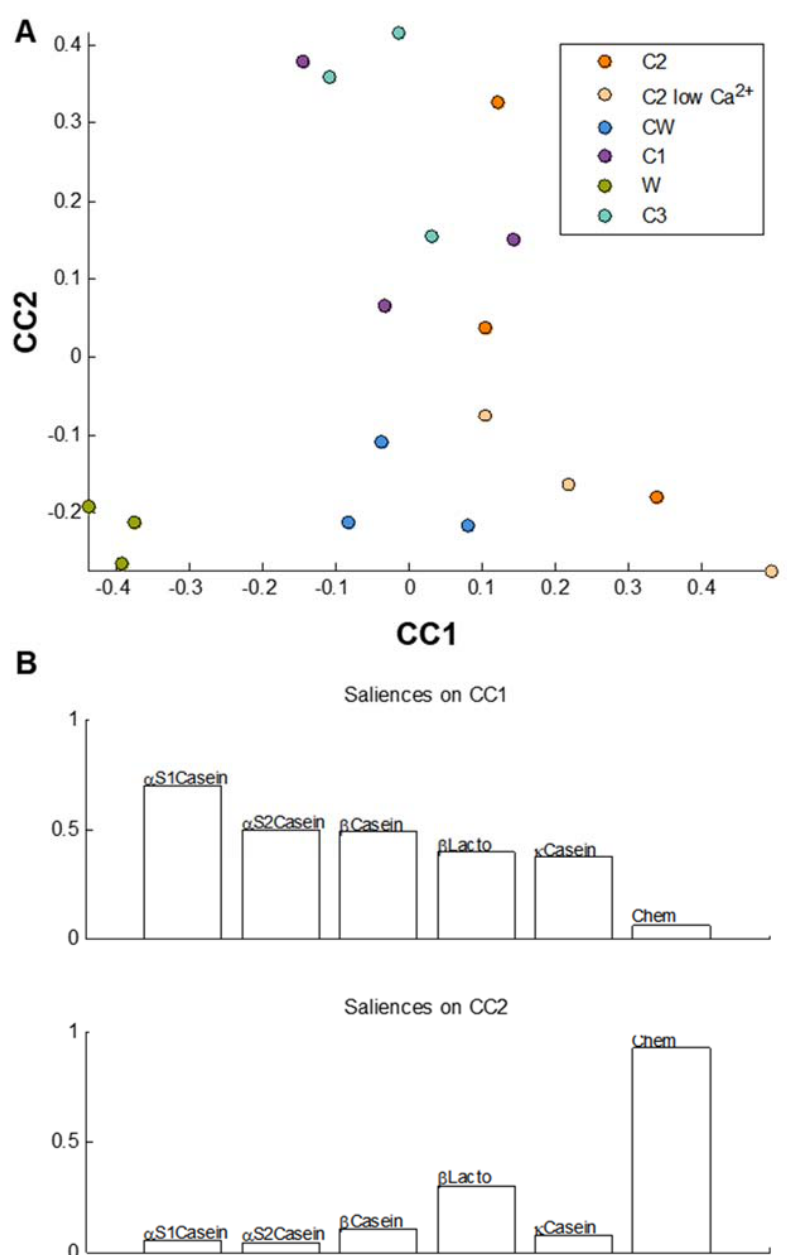
Figure 7. CCSWA of the different matrices at the end of the intestinal phase for all three replicates of the matrices: ( A ) CC1 vs. CC2 scores plot and ( B ) saliences on CC1 and CC2.